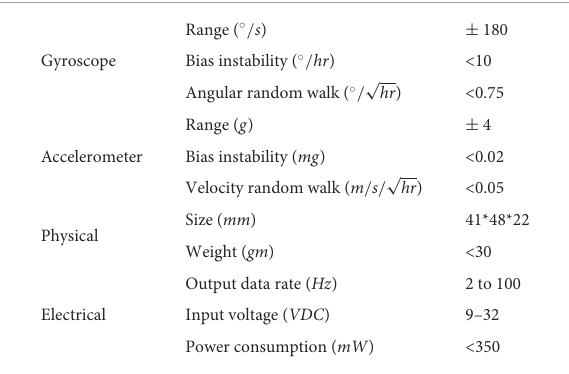
TABLE 1 The specifications of the